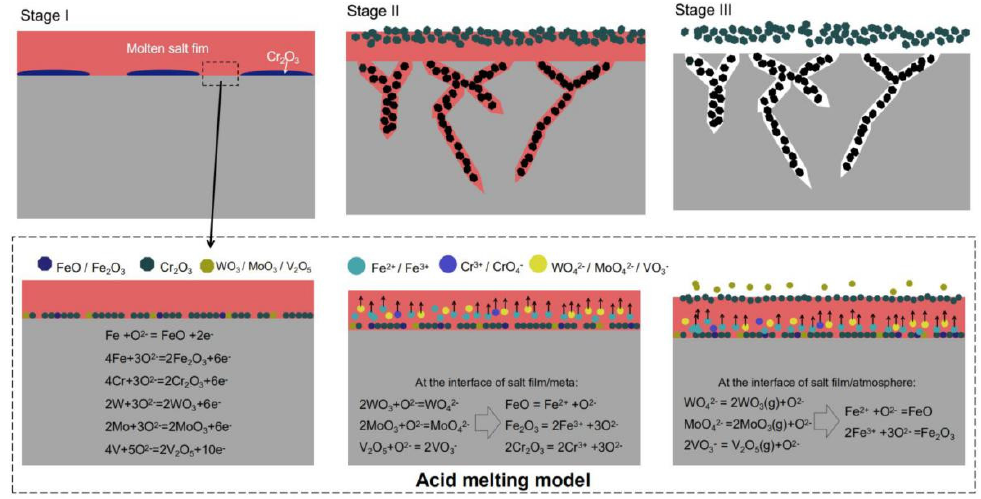
Figure 12. Schematic illustration of the hot corrosion model of MSS covered by NaCl + Na 2 SO 4 eutectic molten salt film.